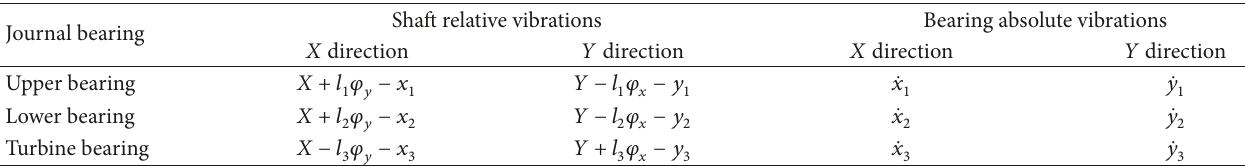
Table 3: Shaft relative vibrations measured by proximity transducers (in displacement) and bearing absolute vibrations measured by piezo- electric accelerometers and integrated by charge amplifiers (in velocity). Journal